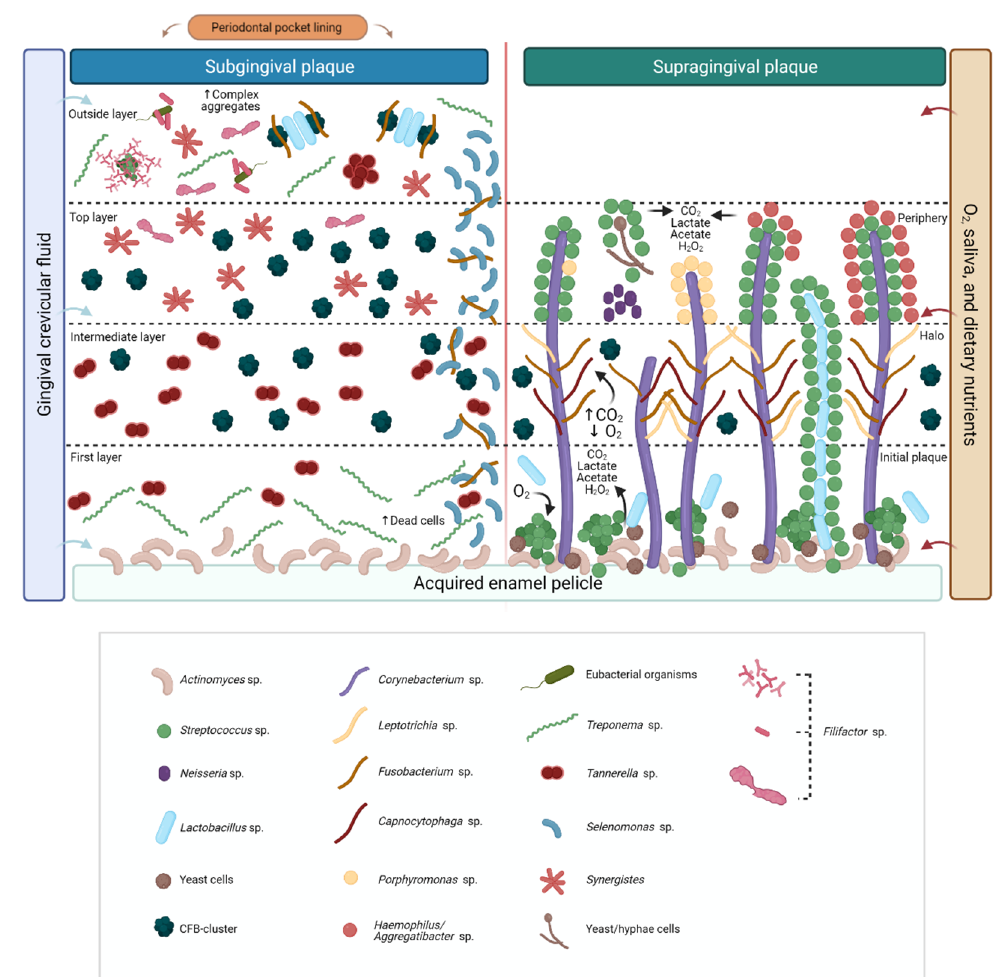
Figure 7. Summary hypothesis for the interpretation of the gathered evidence. Microorganisms that thrive in the subgingival environment, in contrast to bacteria in supragingival biofilm, are cut off from high oxygen stress, salivary, and dietary nutrients, depending on gingival crevicular fluid (GCF) for nutrition. The adsorbing of salivary proteins and glycoproteins to the tooth’s surface triggers the initial plaque establishment, forming the acquired enamel pellicle (AEP)—a conditioning layer for bacterial attachment. In the supragingival biofilm, Corynebacterium sp. filaments bind to an existing biofilm containing Streptococcus sp., Actinomyces sp., yeast cells, and Lactobacillus sp. These species produce carbon dioxide (CO 2 ), lactate, and acetate, containing hydrogen peroxide (H 2 O 2 ) by consuming oxygen (O 2 ). The redox potential is lowered, allowing strict anaerobes (such as Fusobacterium sp., Leptotrichia sp., and Capnocytophaga sp.) to settle and multiply in the CO 2 -requiring “halo” section. This environment is also favorable to the growth and development of microorganisms from the Cytophaga-Flavobacterium-Bacteroides cluster (CFB-cluster), especially, Prevotella sp. In the periphery, cells shape single- or double-layered corncobs structures. Streptococcus sp. adheres to a central axis of yeast/hyphae, Corynebacterium sp., or Lactobacillus sp. cells. Subgingival biofilm is divided into four layers: (i) the first layer, which is made of early colonizers displaying few fluorescences; (ii) the intermediate and (iii) the top layers are composed of a variety of microorganisms from the CFB-cluster, Treponema sp., Tannerella sp., Synergistetes , and Fusobacterium sp. tangled with Selenomonas sp. in the cervical portion; (iv) the outside layer, made of Treponemes nearby a complex mixture of CFB- cluster, Lactobacillus sp. and Fusobacterium sp. cells coaggregated in fine test-tube brushes. Tannerella sp. and Synergistetes formed aggregates solely with themselves. In this last layer, Filifactor sp. form a variety of concentrical-orientated structures, tree-like shapes among coccoid cells, palisades around eubacterial organisms, or remote test-tube-brush shapes.